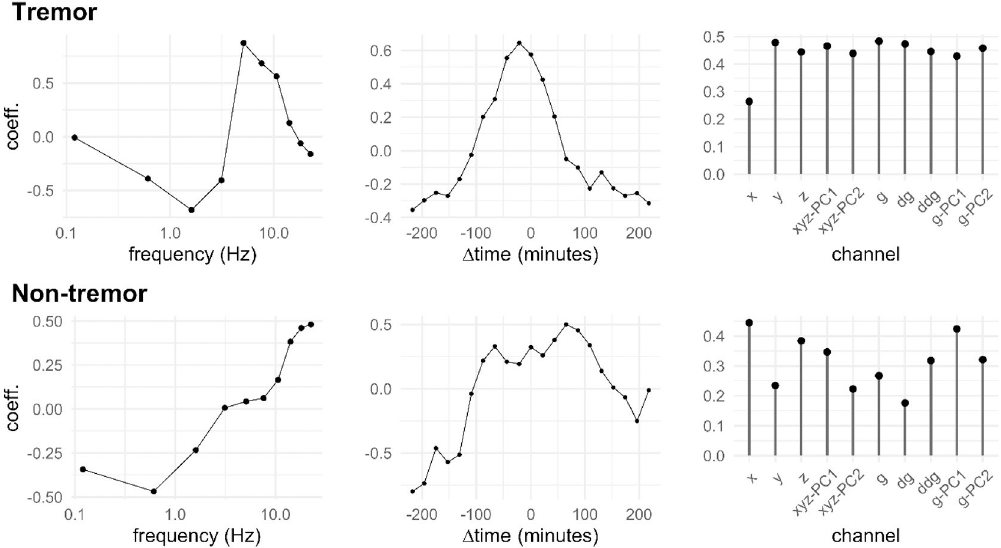
Fig 4. Spectral, temporal, and across-channel envelopes of tremor symptom data (top) and rest of the symptoms data (bottom).